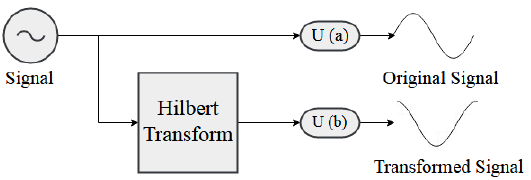
Figure 9. Single to Three-Phase Conversion by Hilbert